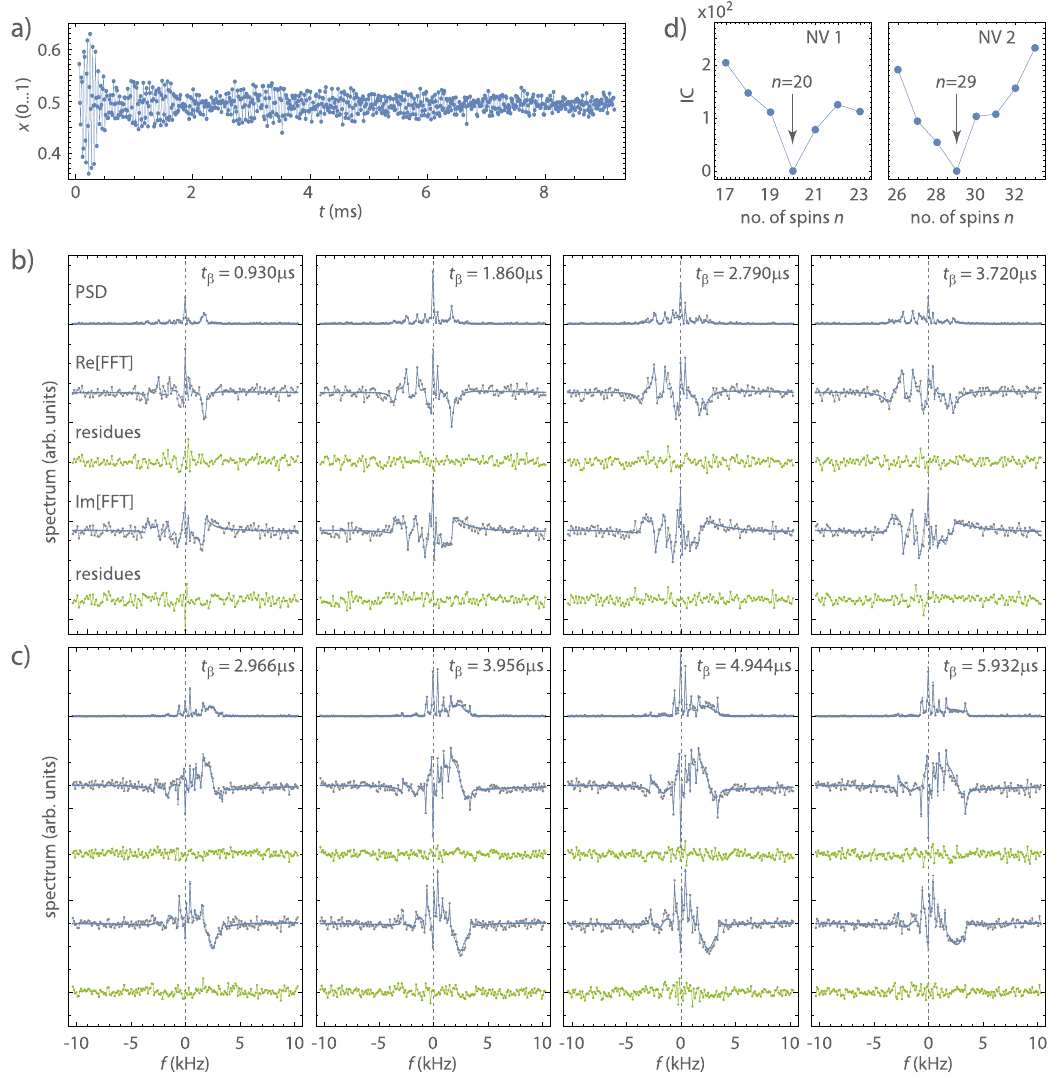
Fig. 4 Experimental demonstration of 13 C NMR spectroscopy of large spin clusters. a Example FID trace from NV2. Each data point re fl ects the probability amplitude x ( t ) from one read-out block, integrated over ~10 6 repetitions of the full sequence (see Fig. 2). Measurement parameters are t = 40 ms, t = 11.48 μ s, t β = 4.944 μ s and K = 800, and total measurement time is 11 h. b Complex Fourier spectra of the 13 C environment of NV1 for a pol s series of interaction times t β . Shown are from top to bottom (vertically offset for clarity): power spectrum (PSD), real part of the complex spectrum (Re ½ FFT (cid:4) ), fi t residues for Re ½ FFT (cid:4) , the imaginary part of the complex spectrum (Im ½ FFT (cid:4) ), and fi t residues for Im ½ FFT (cid:4) . Blue traces are best fi ts (see text). The horizontal axis shows the spectral shift relative to the 13 C Larmor frequency at 2.156 MHz calibrated using correlation spectroscopy 54 . The bias fi eld is B = 201.29 mT. The PSD data of NV1 are the same as in ref. 36 , Extended Data Fig. 5a. c Fourier spectra of the 13 C environment of NV2. Bias fi eld is 0 B = 188.89 mT. d Cost function (IC, Eq. (8)) plotted as a function of the number of spins n . Best fi ts are obtained for n = 20 (NV1) and n = 29 (NV2). 0 Since only differences in the cost function are meaningful, the minimum of the IC has been set to